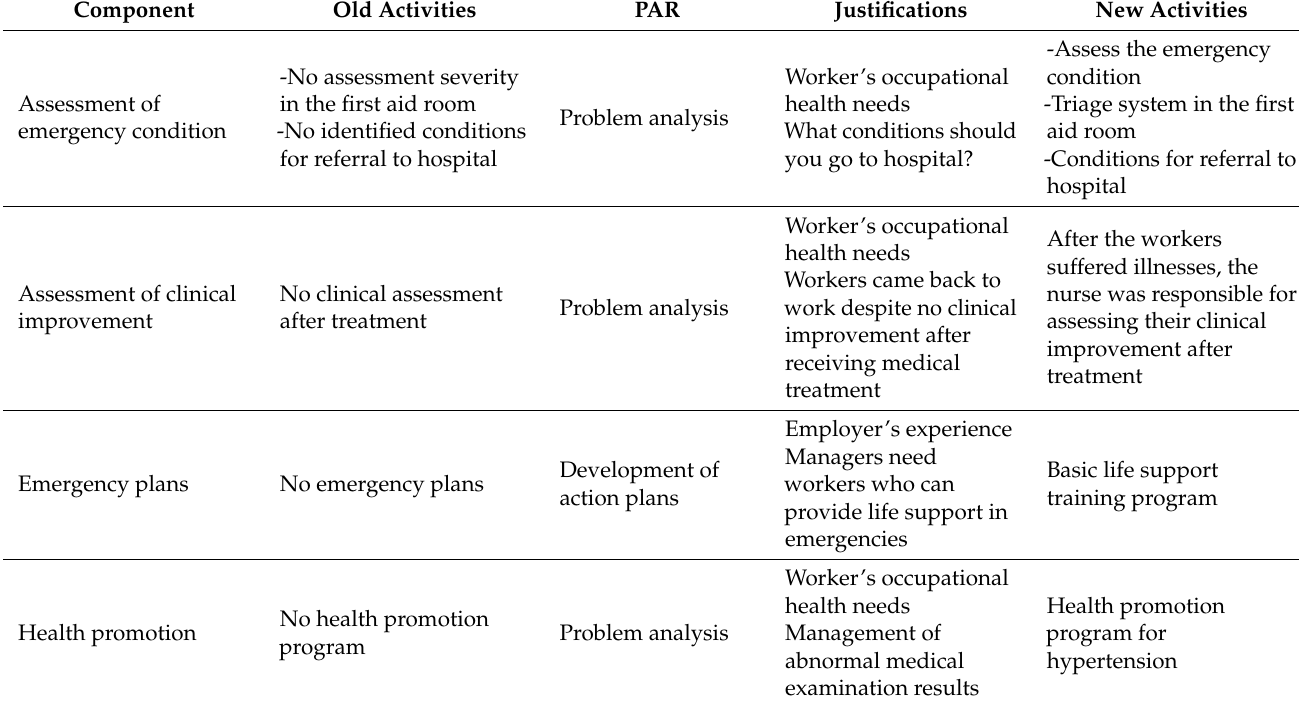
Table 14. First aid room model